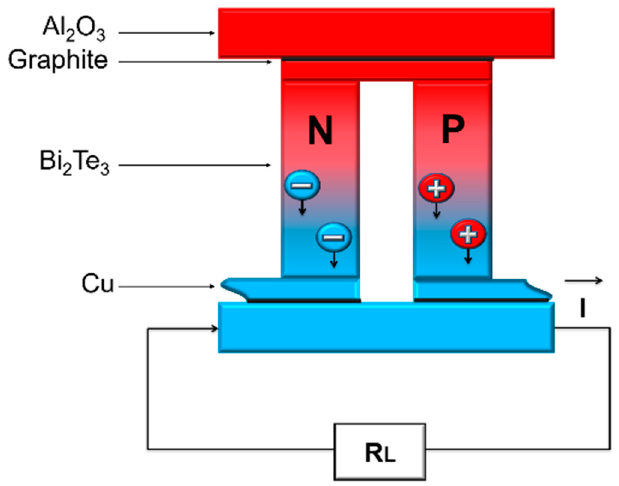
Figure 1. Representation of the operation of a thermoelectric pair and of the materials that compose the Thermoelectric Generator (TEG) under study (TEHP 1263-1.5).